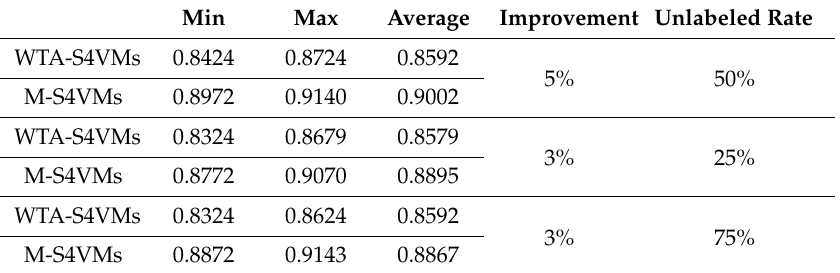
Table 7. Outcome of the total accuracy rate at different unlabeled rates.